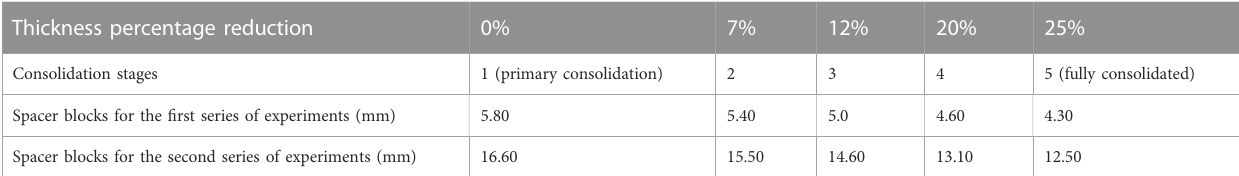
TABLE 3 Series of experiments for morphology evolution and thermal conductivity measurements. The thickness percentage reduction was calculated relative to the primary consolidation stage. Thickness percentage